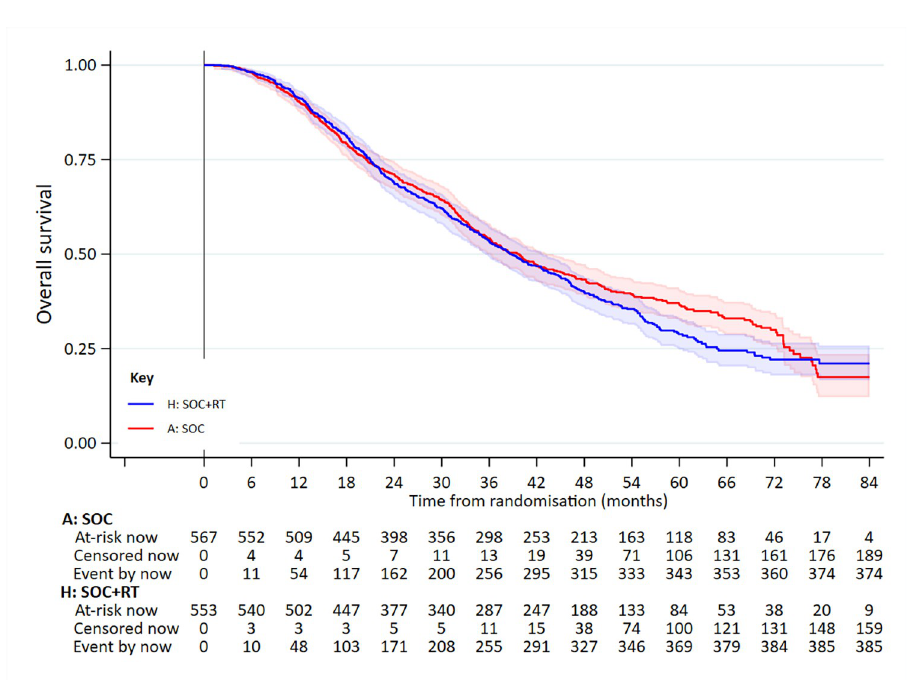
Fig 4. OS in patients in the high-burden metastatic disease group. Adjusted HR = 1.11 (95% CI 0.96 to 1.28; p = 0.164). HR, hazard ratio; OS, overall survival; RT, radiotherapy to the prostate; SOC, standard of care.